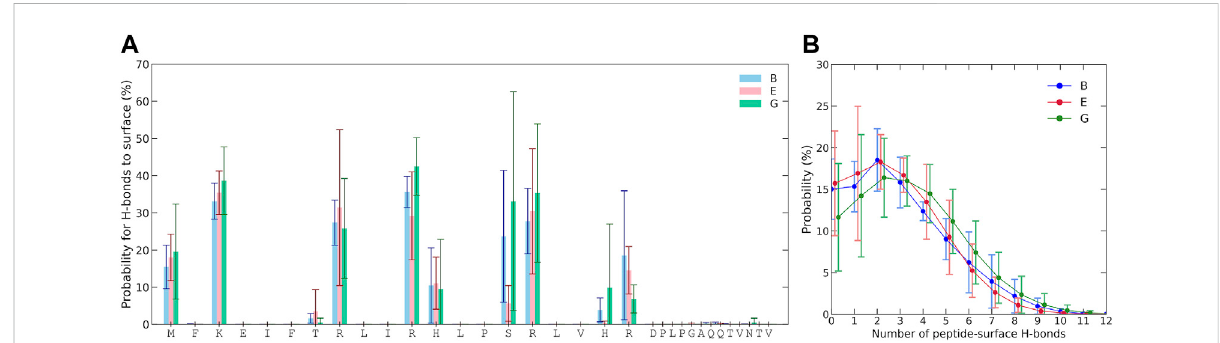
FIGURE 5 (A) Probability of multiple hydrogen bonds between KEIF and Laponite ® during the simulations and the probability of at least one hydrogen bondisincludedinthelegend. (B) Probabilityforeachresiduetothehydrogenbond.Resultsareshownfortheforce fi eldandwatercombinationsB, E, and G. Error bars represent the standard deviation between replicates.